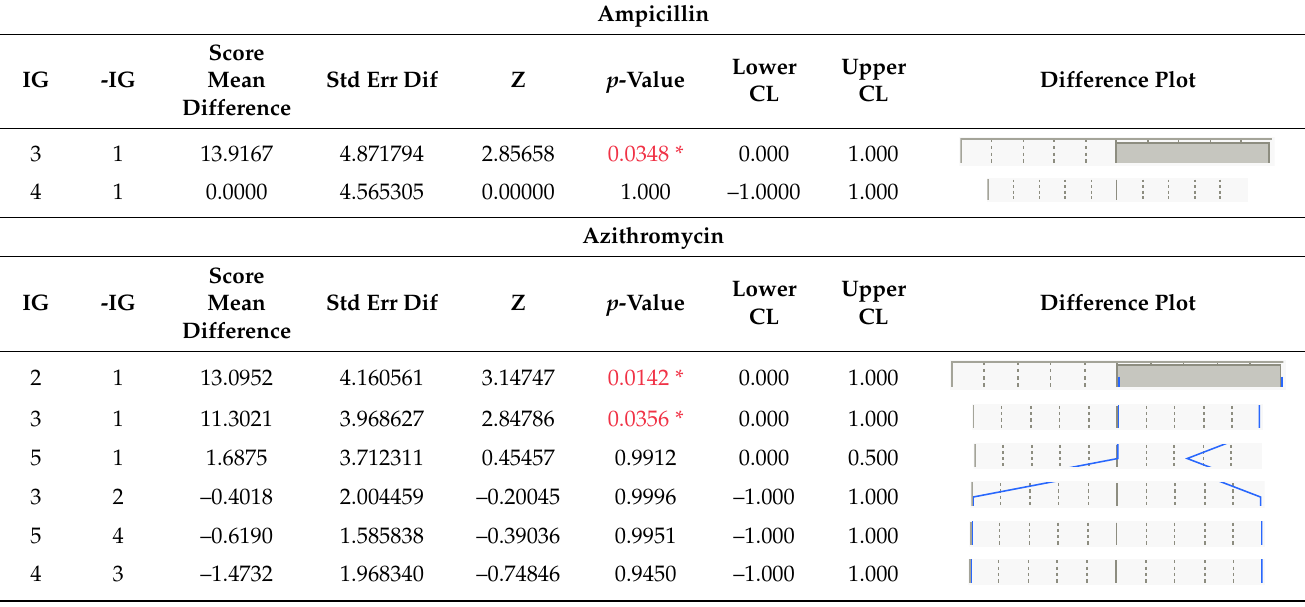
Test results for association between date of sample collection and resistance for each antibiotic. An- tibiotics highlighted in yellow show an upward trend over the last 10 years. The p values highlighted in red illustrate the significant trends. The difference plots show a measure of strength and direction of association using the grey bars in the far-right column. Table 3. Results for association between Staphylococcal isolate groups and antibiotic resistance. Ampicillin